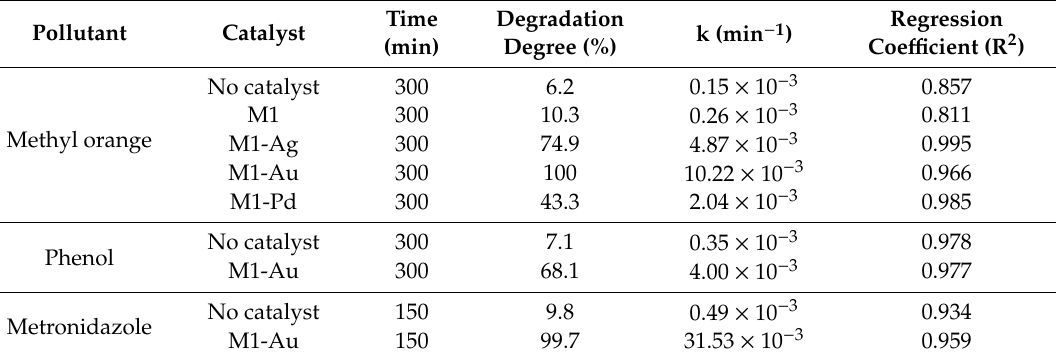
Table 2. Photodegradation parameters (degradation degree and apparent rate constant, k) for the decomposition of di ff erent pollutants (methyl orange, phenol, metronidazole) under visible